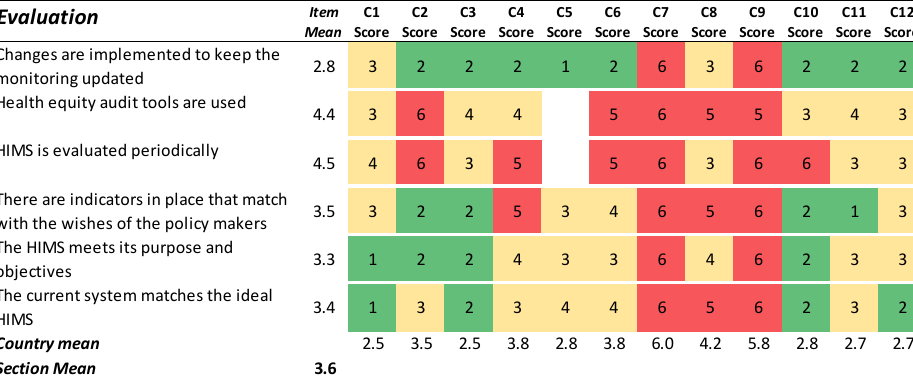
Figure 5. Results for the section ‘Evaluation’. Green cells (scores 1–2) indicate agreement with the statement. Yellow cells (scores 3–4) indicate partial agreement/disagreement, and red cells (scores 5–6) indicate the most challenging preconditions for an ideal HIMS.